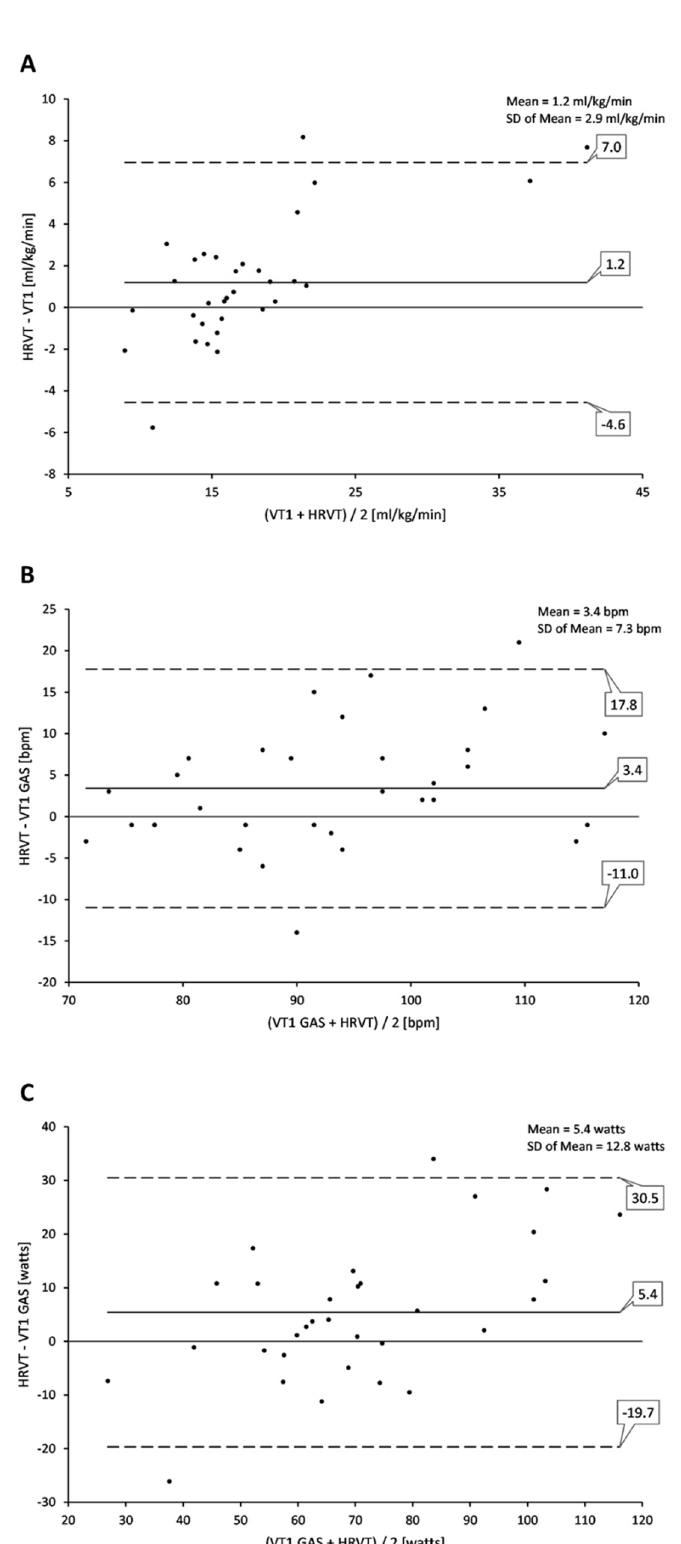
Figure 2. Bland–Altman plot of VT1 vs. HRVT for all participant ramp tests performed. ( A ) VT1 vs. HRVT for VO 2 ; ( B ) VT1 vs. HRVT for HR; ( C ) VT1 vs. HRVT for cycling power. Center line in each plot represents the mean difference (bias) between each paired value, the top and bottom dashed lines are 1.96 standard deviations from the mean difference.